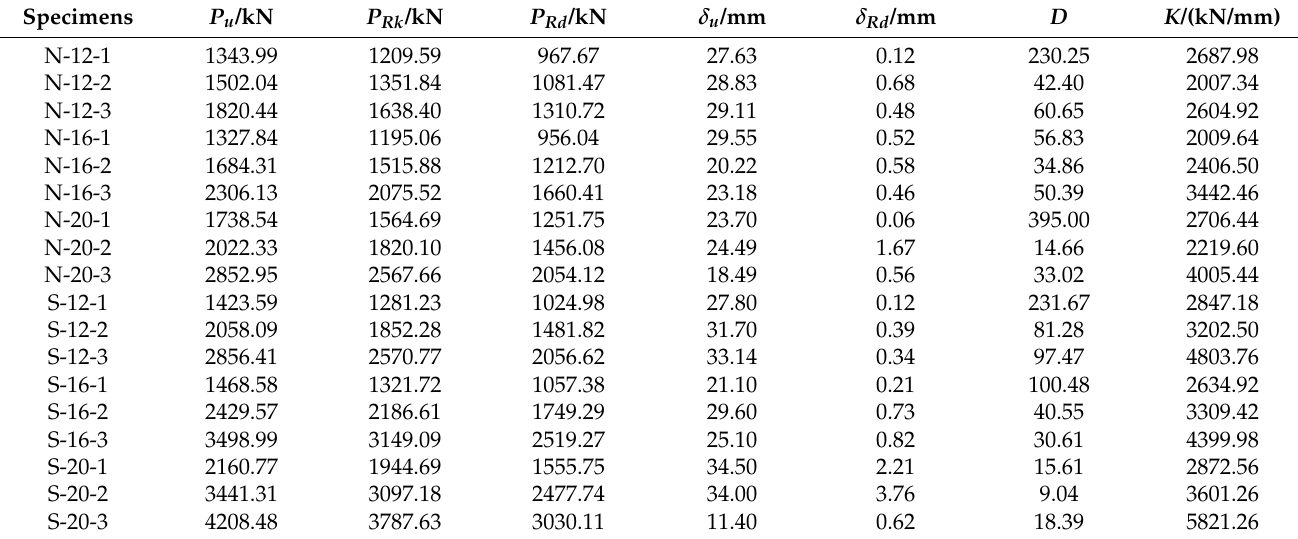
Table 3. Static performance of each